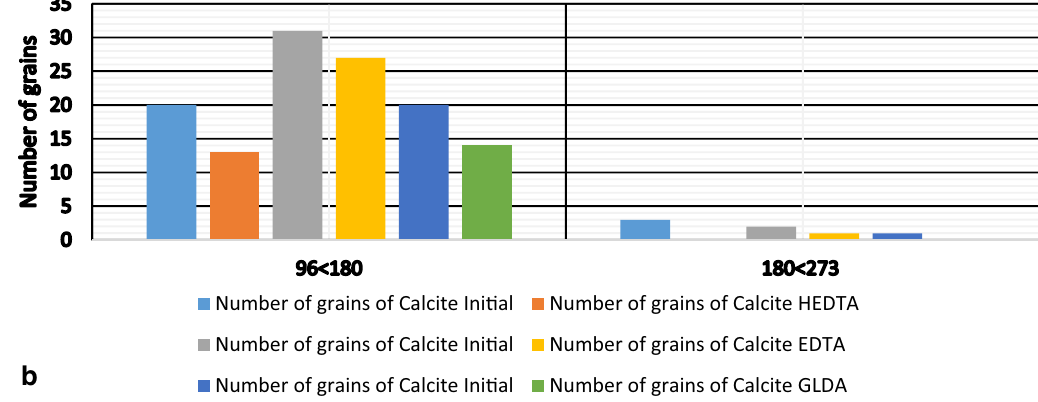
Fig. 17 The grain size distribution of calcite in Colton Sandstone before and after reaction with chelating